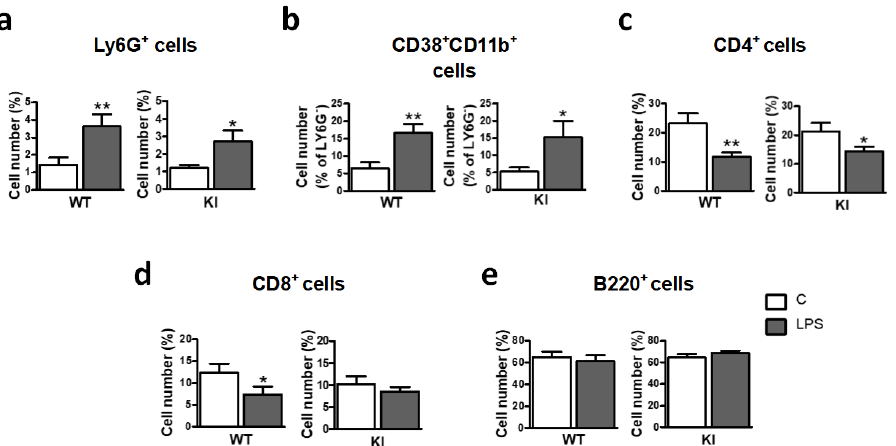
Figure 5. Similar peripheral immune response to LPS in GSK3 β Ser 389 KI and WT mice. Adult WT and GSK3 β Ser 389 KI mice were i.p. injected with LPS. After 3 days, spleen cells were extracted and processed to evaluate, by flow cytometry, the number of ( a ) Ly6G + neutrophils, ( b ) CD38 + CD11b + monocytes/macrophages, ( c ) CD8 + , ( d ) CD4 + , and ( e ) B220 + cells. Histograms show the effects of LPS on cell number, including WT and KI mice. Student t-test was applied to evaluate the significance of changes induced by LPS in each genotype. Mean ± S.E.M is shown ( n = 5 – 7). *, p < 0.05; **, p < 0.01.